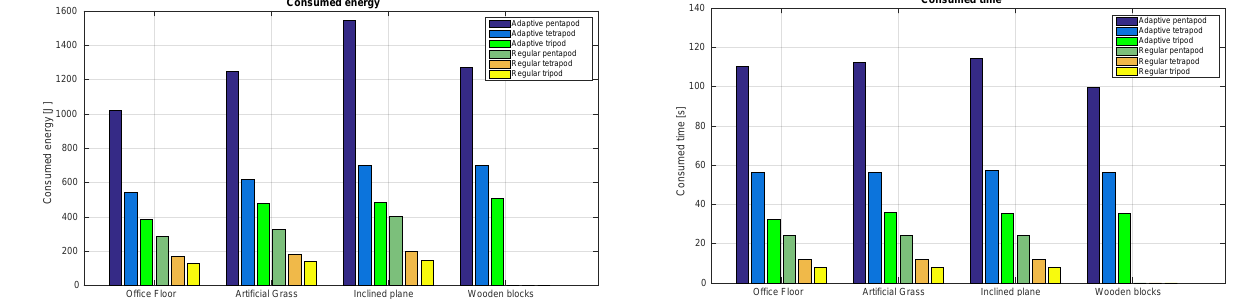
Figure 4. Traversing time on different terrain